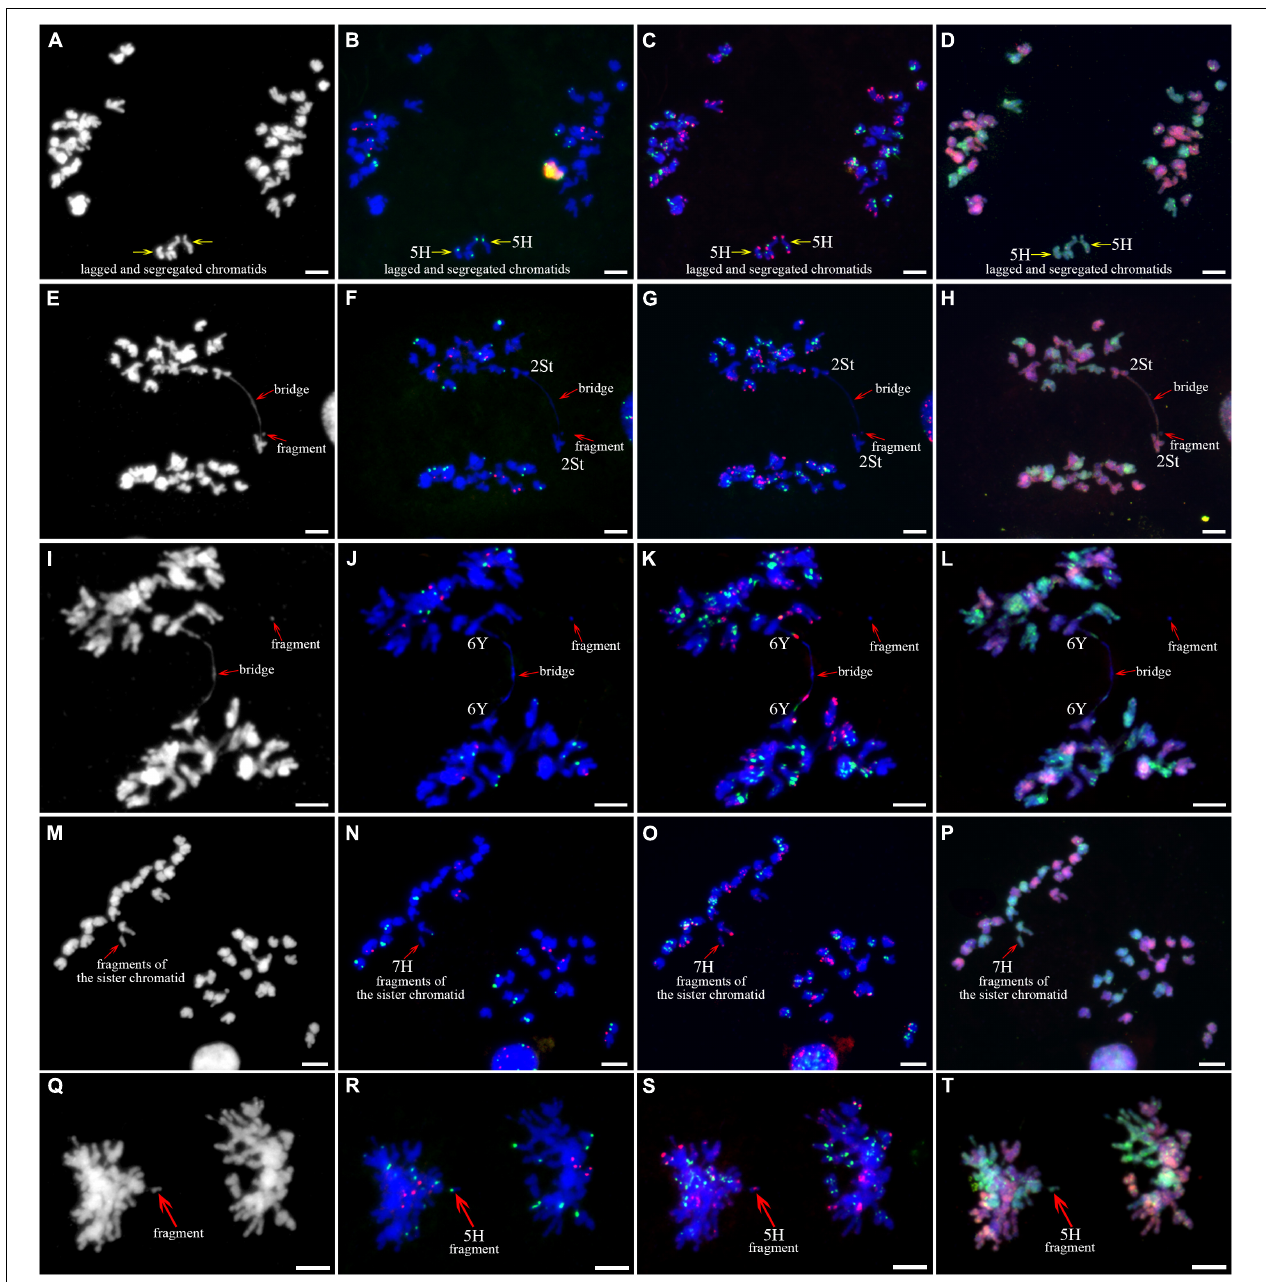
FIGURE 4 | Sequential fluorescence in situ hybridization (FISH) of meiotic anaphase I of plant A02-1 of E. nutans. (A,E,I,M,Q) Chromosomes stained with DAPI; (B,F,J,N,R) pTa71-2 (red) and pSc119.2 (green); (C,G,K,O,S) pAs1 (red) and (AAG) 10 (green); (D,H,L,P,T) genomic DNA probes of P. stipifolia (red) and H. bogdanii (green). Bars = 10 µ